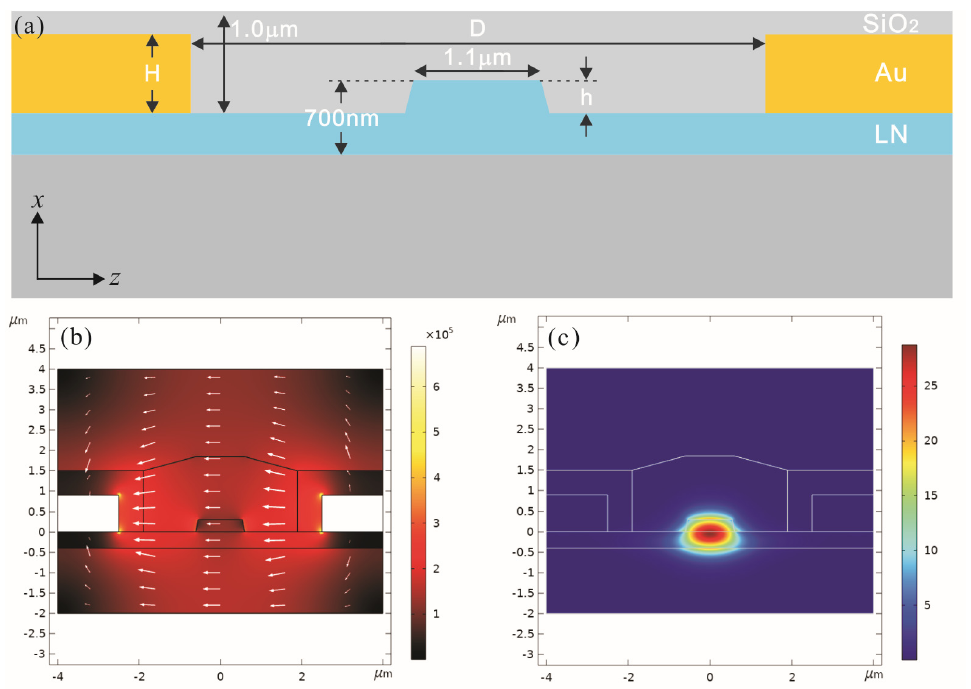
Figure 2. ( a ) The cross − sectional structure and dimensions of the modulation area; ( b ) The electro- static field of two electrodes; ( c ) The optical field of the transverse electric (TE) mode.